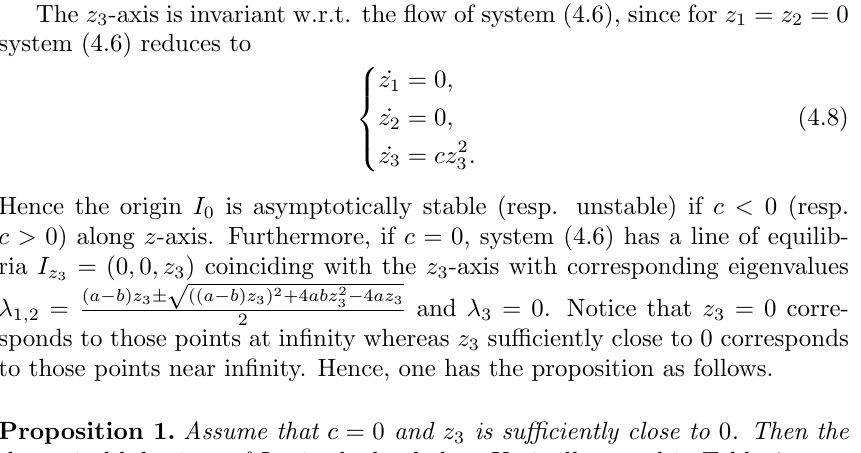
− 1 | z 1 | 2 | z 1 | z 1